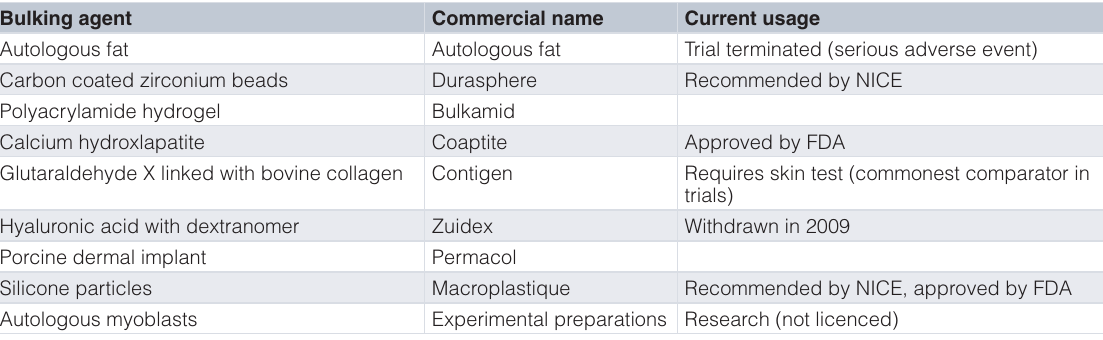
Table 3. Periurethral bulking agents for stress